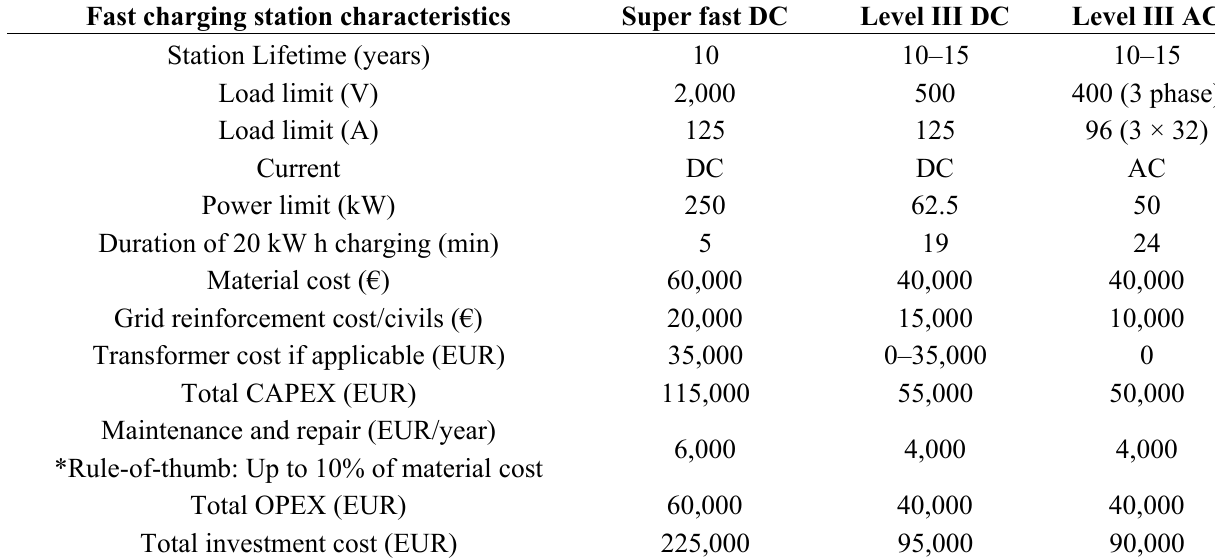
Table 5. Summary of EV fast charging costs [11]. DC: direct current; and